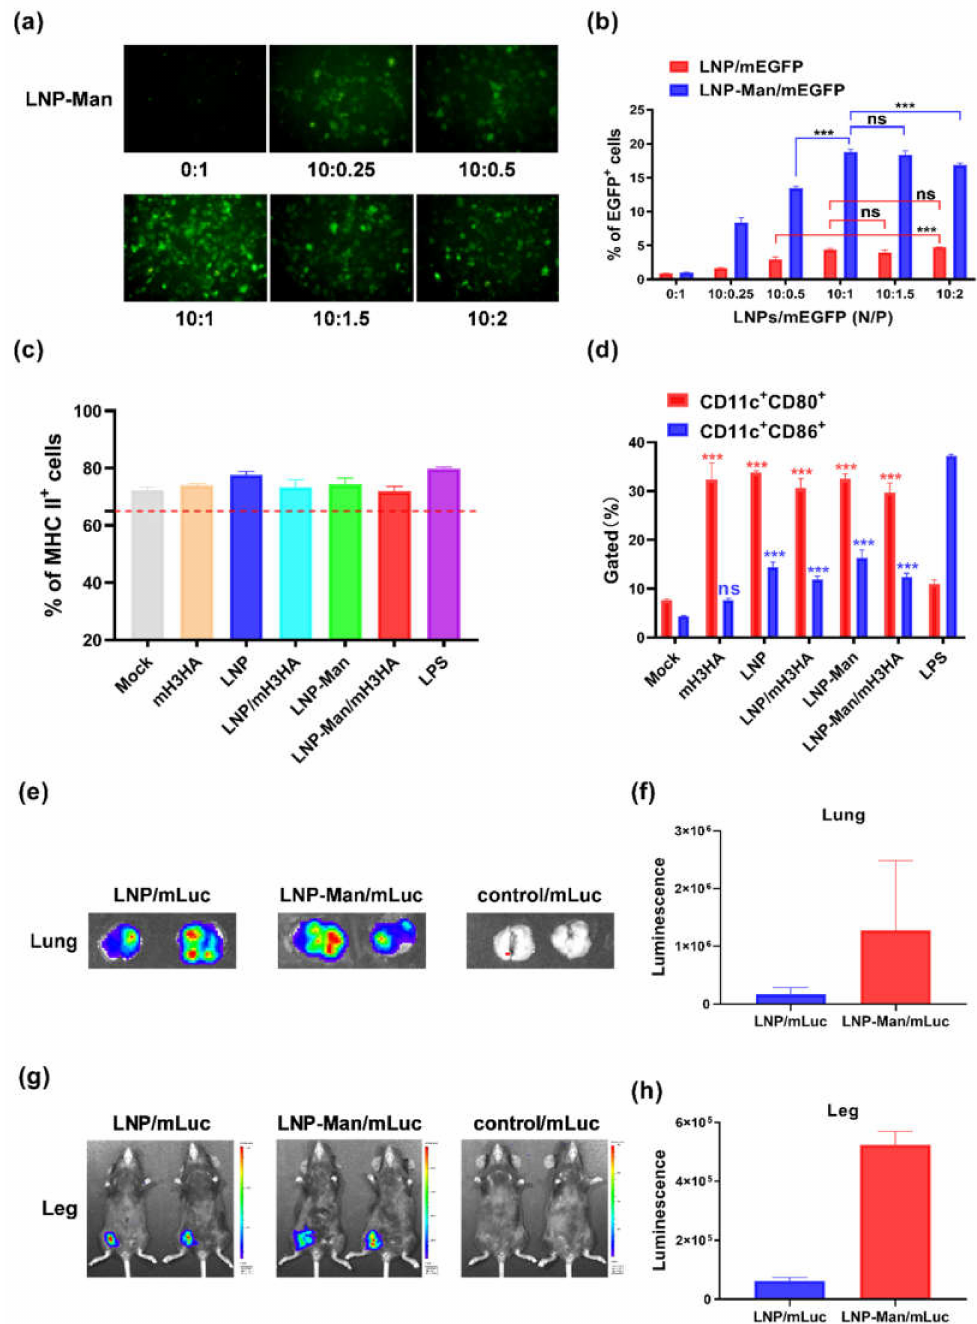
Figure 3. Functional verification of LNPs / mRNA. ( a ) Fluorescence microscope imaging. A549 cells transfected with LNP-Man / mEGFP at indicated N / P molar ratios were observed under a fluorescence microscope 12 h after transfection. ( b ) The EGFP positivity rates of cells transfected with LNPs / mEGFP at indicated N / P molar ratios were detected by flow cytometry. Data are shown as means ± SDs and were analyzed by two-way ANOVA ( n = 3, ns p > 0.05; *** p < 0.0001). ( c , d ) Flow cytometric analysis of the dendritic cells’ (DC) maturation levels. Data are shown as means ± SDs and were analyzed by two-way ANOVA. ( n = 3, ns p > 0.05; *** p < 0.0001; compared with Mock). ( e , f ) In vivo imaging. Images of lungs were acquired using an IVIS Lumina S5, and bioluminescence intensity from the region of interest was quantified using Living Image software. ( g,h ) In vivo imaging. Images of legs and the bioluminescence